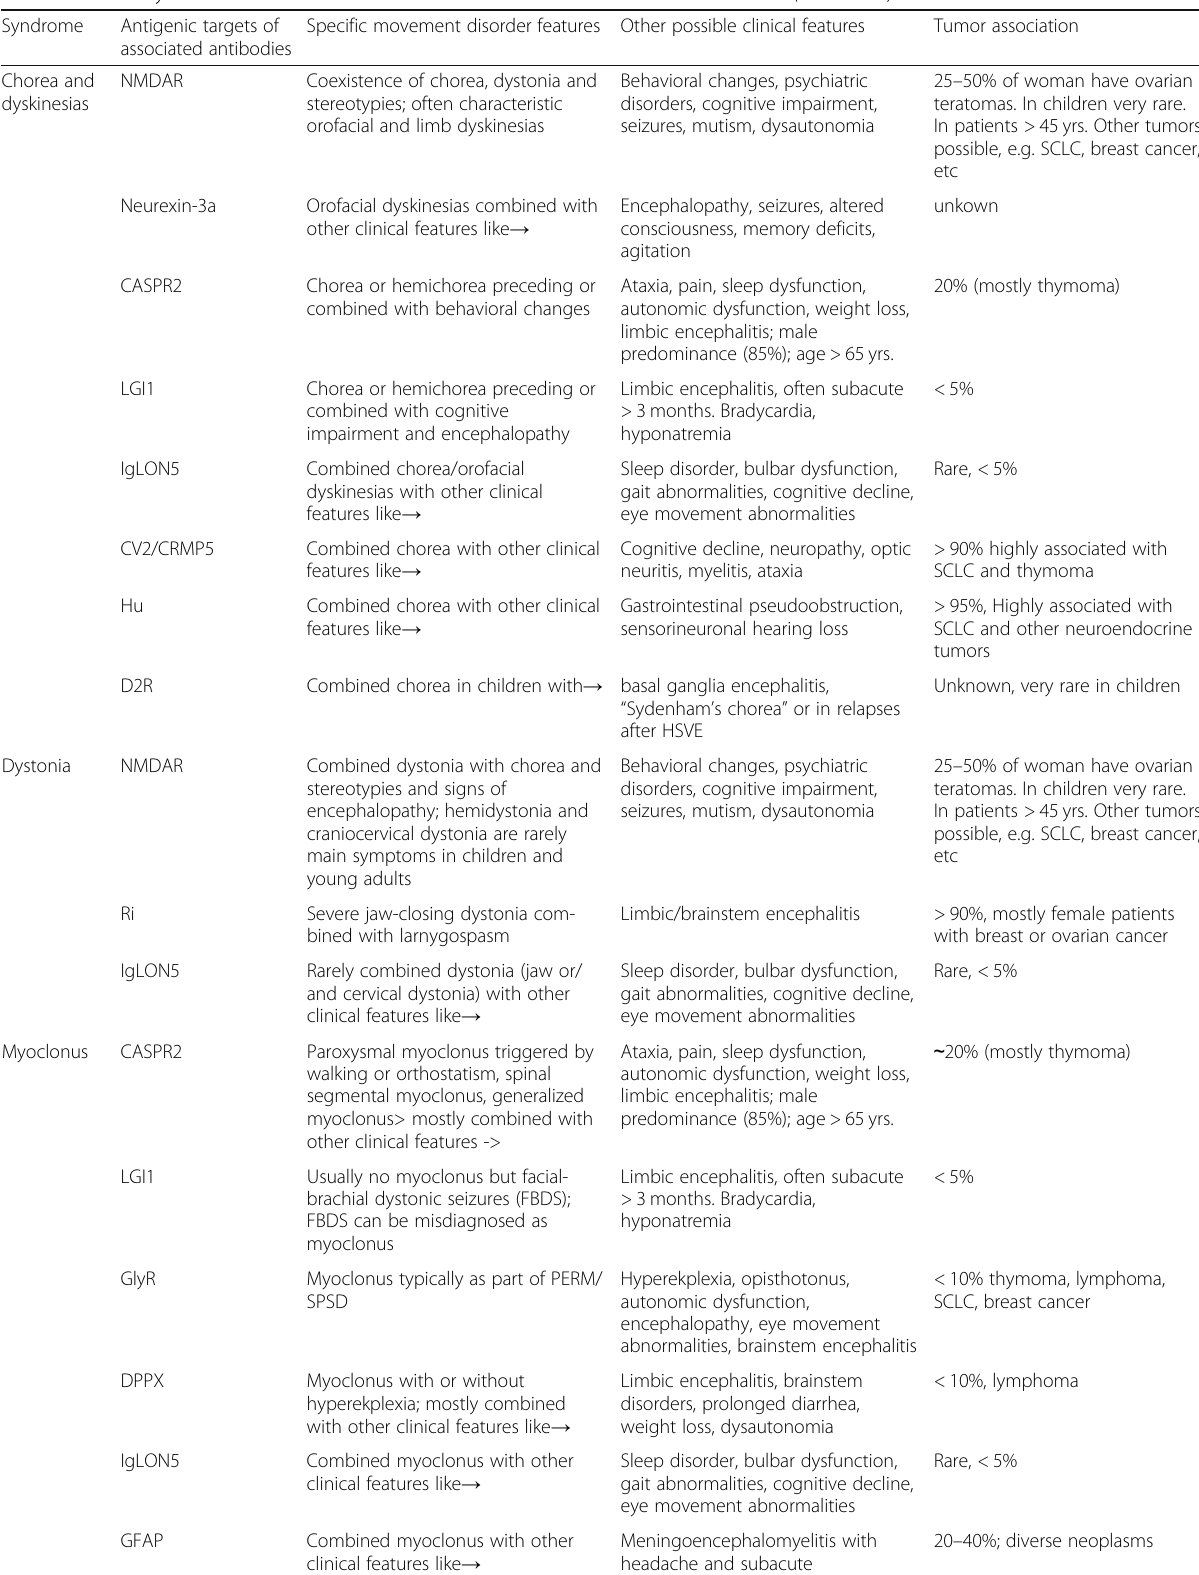
Table 1 Antibody-related movement disorders: Clinical features and tumor association (Continued) Syndrome Antigenic targets of Specific movement disorder features Other possible clinical features Tumor association associated antibodies Chorea and